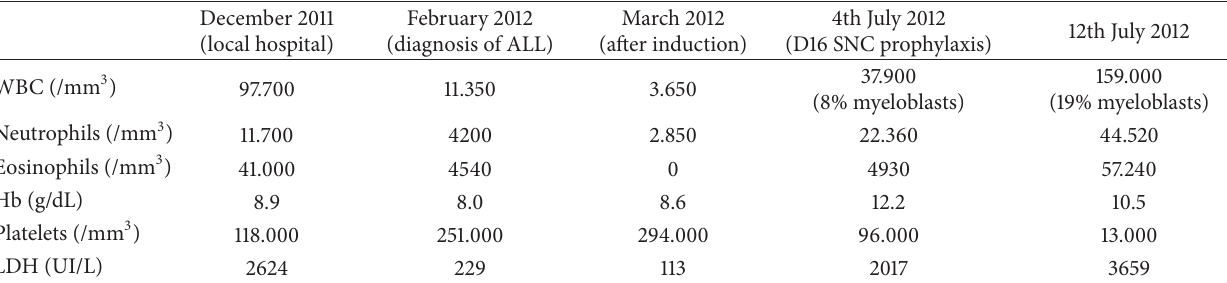
Table 1: Laboratory data.